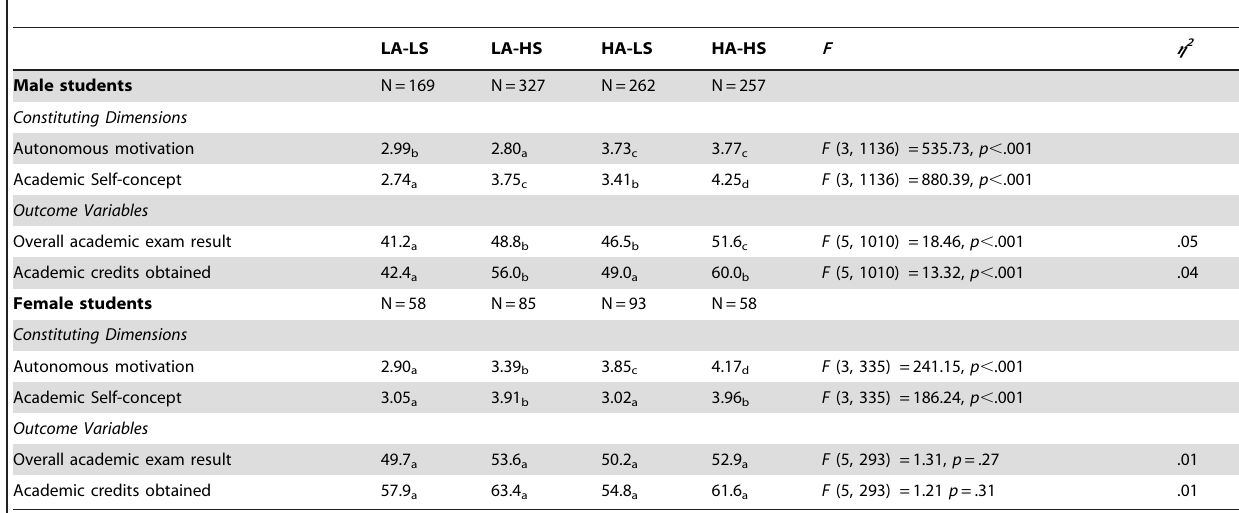
Table 6. Mean Values of the Constituting Dimensions and of Outcome Variables for the four Extracted Clusters of Male and Female